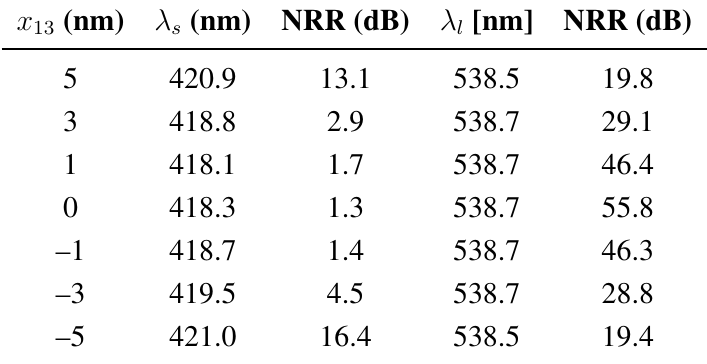
Table 2. The resonant wavelength and the NRR values for the super-resonant states of the 3L NP reported in Figure 2. The core is displaced along the positive and negative x subscript l refers to the longer wavelength where the dipole mode dominates, while s refers to the shorter wavelength, where other, particularly quadrupole, modes are excited together with the dipole